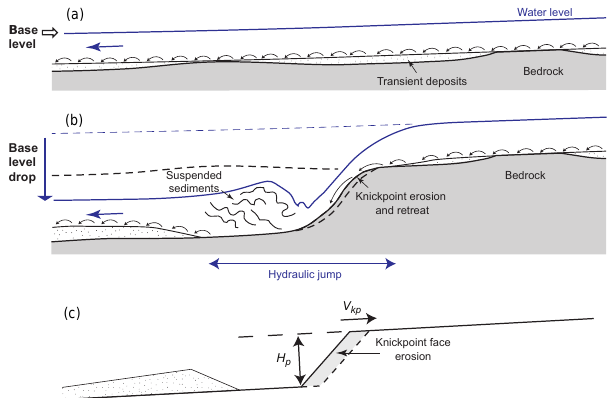
Figure 1. Schematic longitudinal section of a river bed before (a) and during (b) the propagation of a knickpoint triggered by rel- ative base-level fall. Blue arrows represent flow direction and black arrows the motion of the bedload. The black and blue dashed lines respectively represent the bedrock and water levels before knick- point propagation. (c) Idealized representation of a knickpoint char- acterized by its velocity, V kp , and the depth of associated plunge pool, H p .